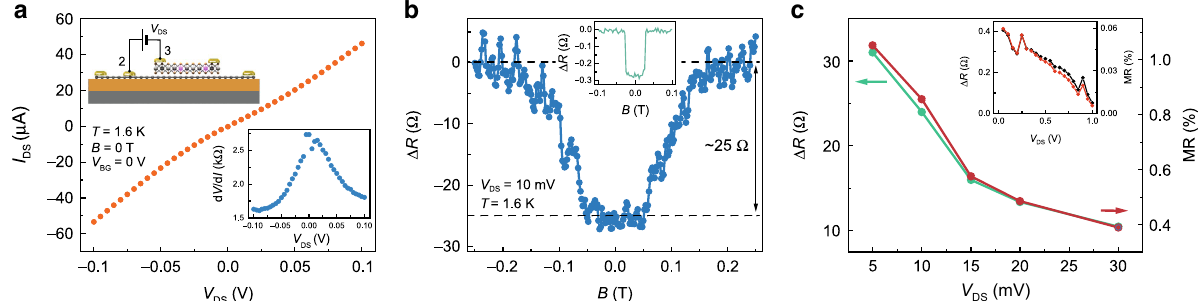
Fig. 2 Vertical transport across monolayer PtSe 2 . a Bias voltage dependence of I DS . Top inset is the schematic of the measurement geometry. Bottom inset is the differential resistance as a function of applied bias. b Magnetic fi eld dependence of electrical resistance measured at T = 1.6 K. The observation of a two-plateau response indicates the presence of antiferromagnetic ground-state ordering. Inset shows the magneto-transport measurements for a ~7- nm-thick metallic PtSe 2 . c Bias dependence of the change in device resistance as a result of the magnetic fi eld and corresponding MR percentage. All measurements are taken at 1.6 K. Inset shows the bias dependence of resistance and MR for a ~7-nm-thick metallic PtSe 2